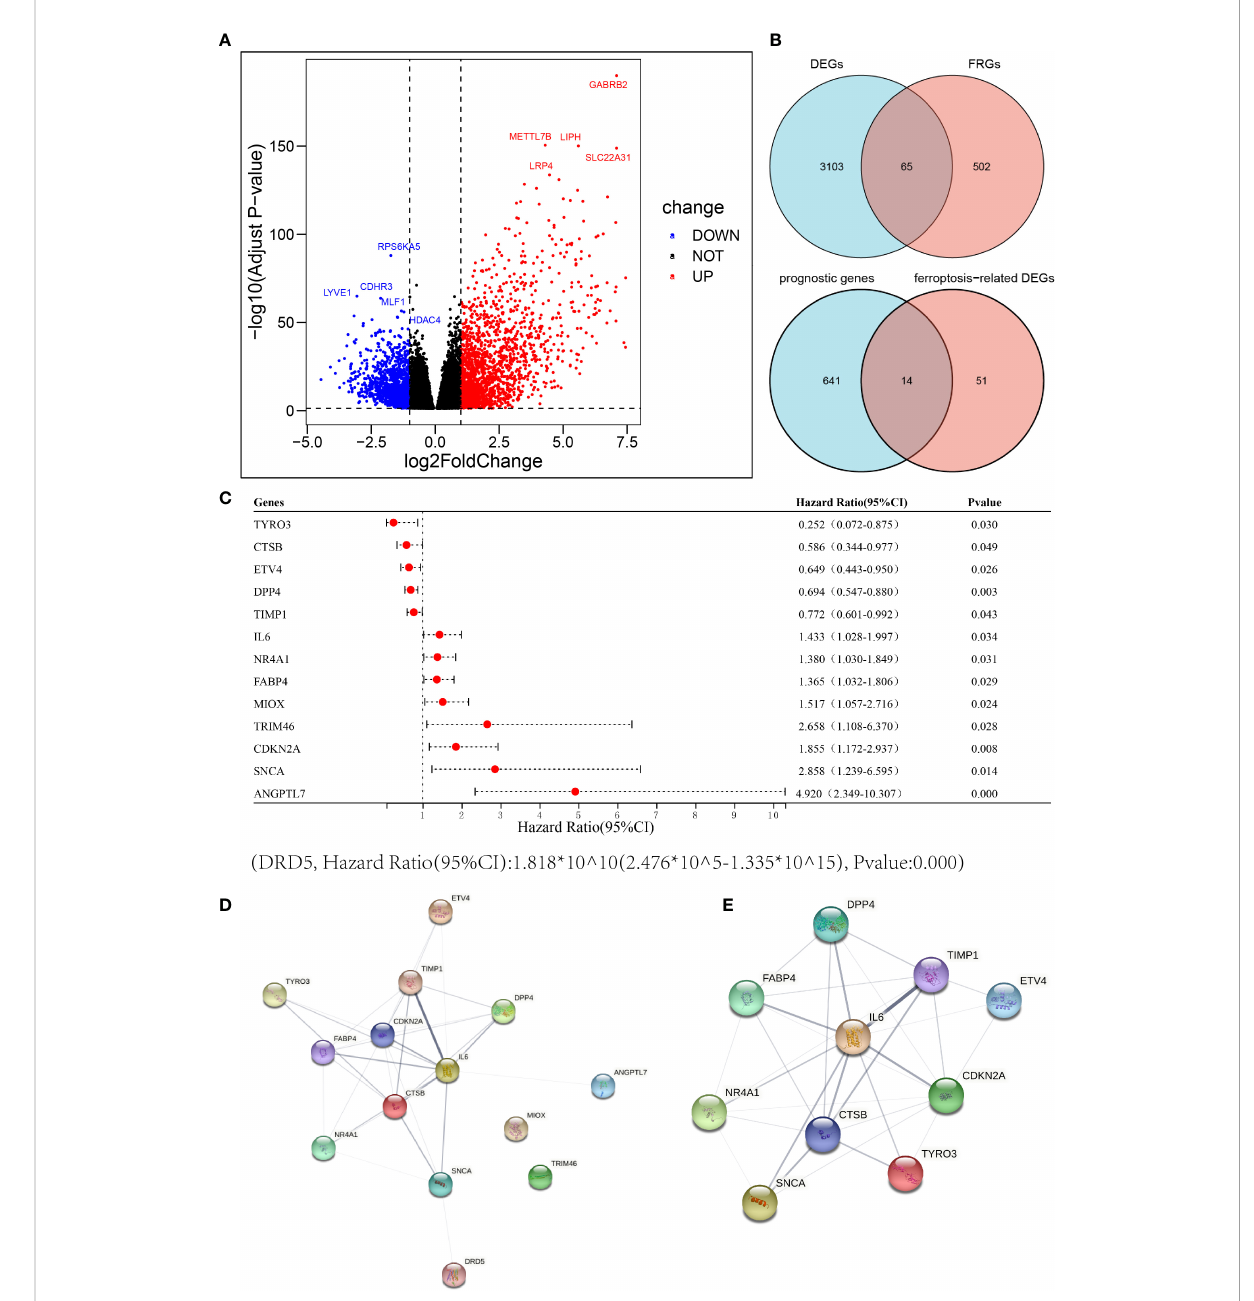
FIGURE 2 Identi fi cation of candidate ferroptosis-related genes in the cancer genome atlas (TCGA) cohort. (A) Differentially expressed genes between THCA and adjacent normal thyroid tissue are shown by a volcano plot. (B) Venn diagrams to identify differentially expressed ferroptosis-related genes between tumor and adjacent normal tissue that were correlated with OS. (C) Univariate Cox regression analysis between gene expression and OS are shown by a Forest plot. (D, E) The PPI network downloaded from the STRING database indicated the interactions among the candidate